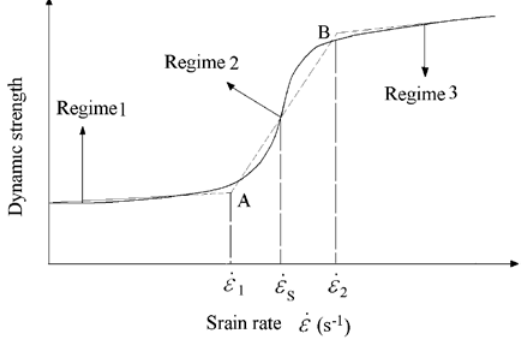
Figure 3: Dependence of failure strain on strain rate of amphibo- lites under compression [38].